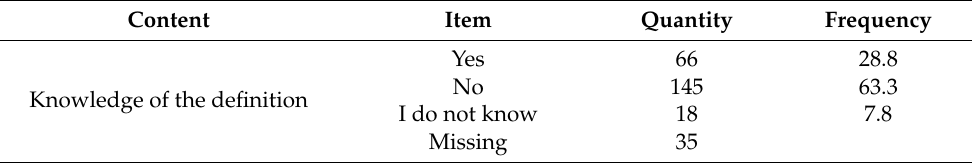
Table 2. Definition of dental neglect (DN) and knowledge of the child protection guideline (N total =